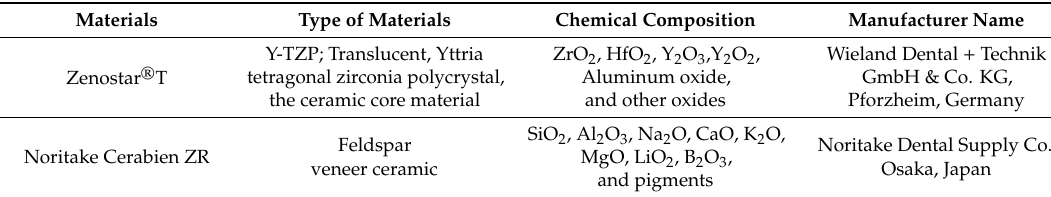
Table 1. The ceramic materials used in the current study.